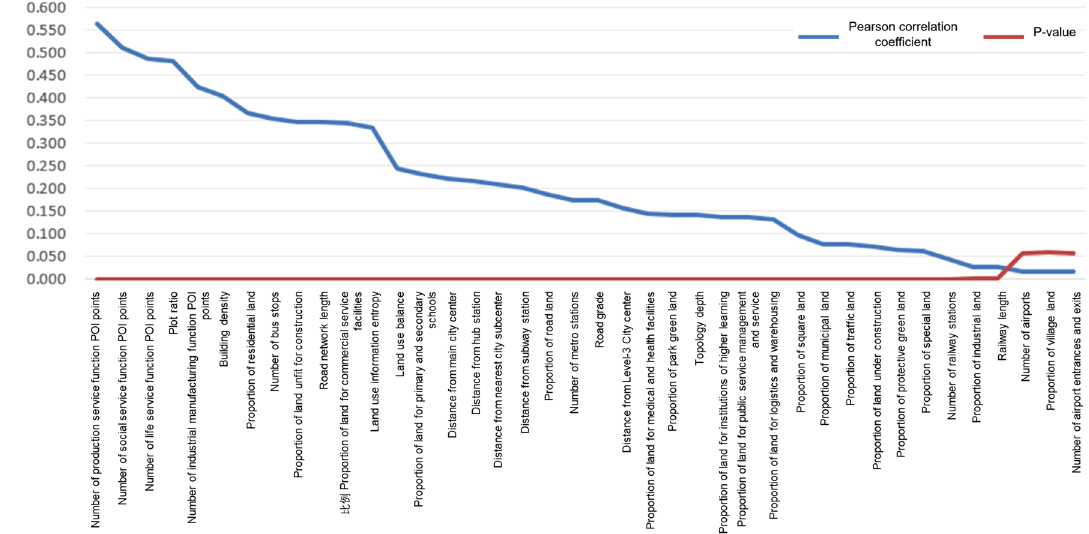
Figure 3. Eigenvalue correlation score and p_value. Source Author